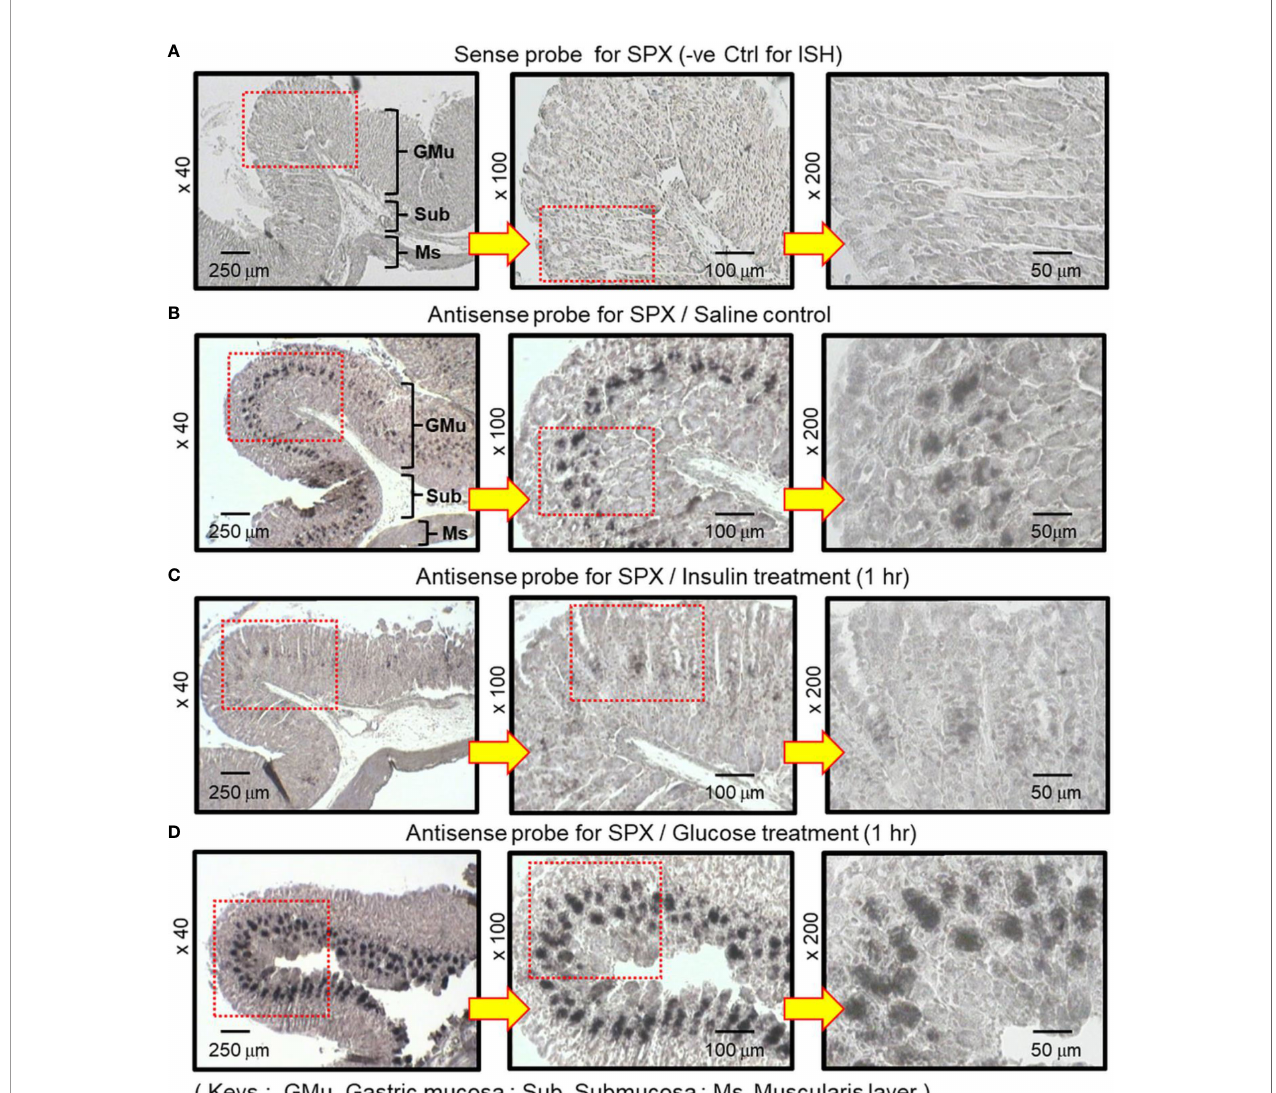
FIGURE 3 | In situ hybridization for SPX expression in the glandular stomach of the mice after treatment with glucose and insulin, respectively. IP injection with glucose (2 g/kg BW) or insulin (3 IU/kg BW) was performed in the mice (with saline injection as control treatment) and the glandular stomach was harvested 1 h after drug treatment. After fi xation and embedding, tissue sections were prepared for in situ hybridization using the antisense riboprobe for SPX. Parallel hybridization with the sense strand of the riboprobe was used as a negative control. The numbers presented on the side (×40, ×100 and ×200) represent the magni fi cation of the respective